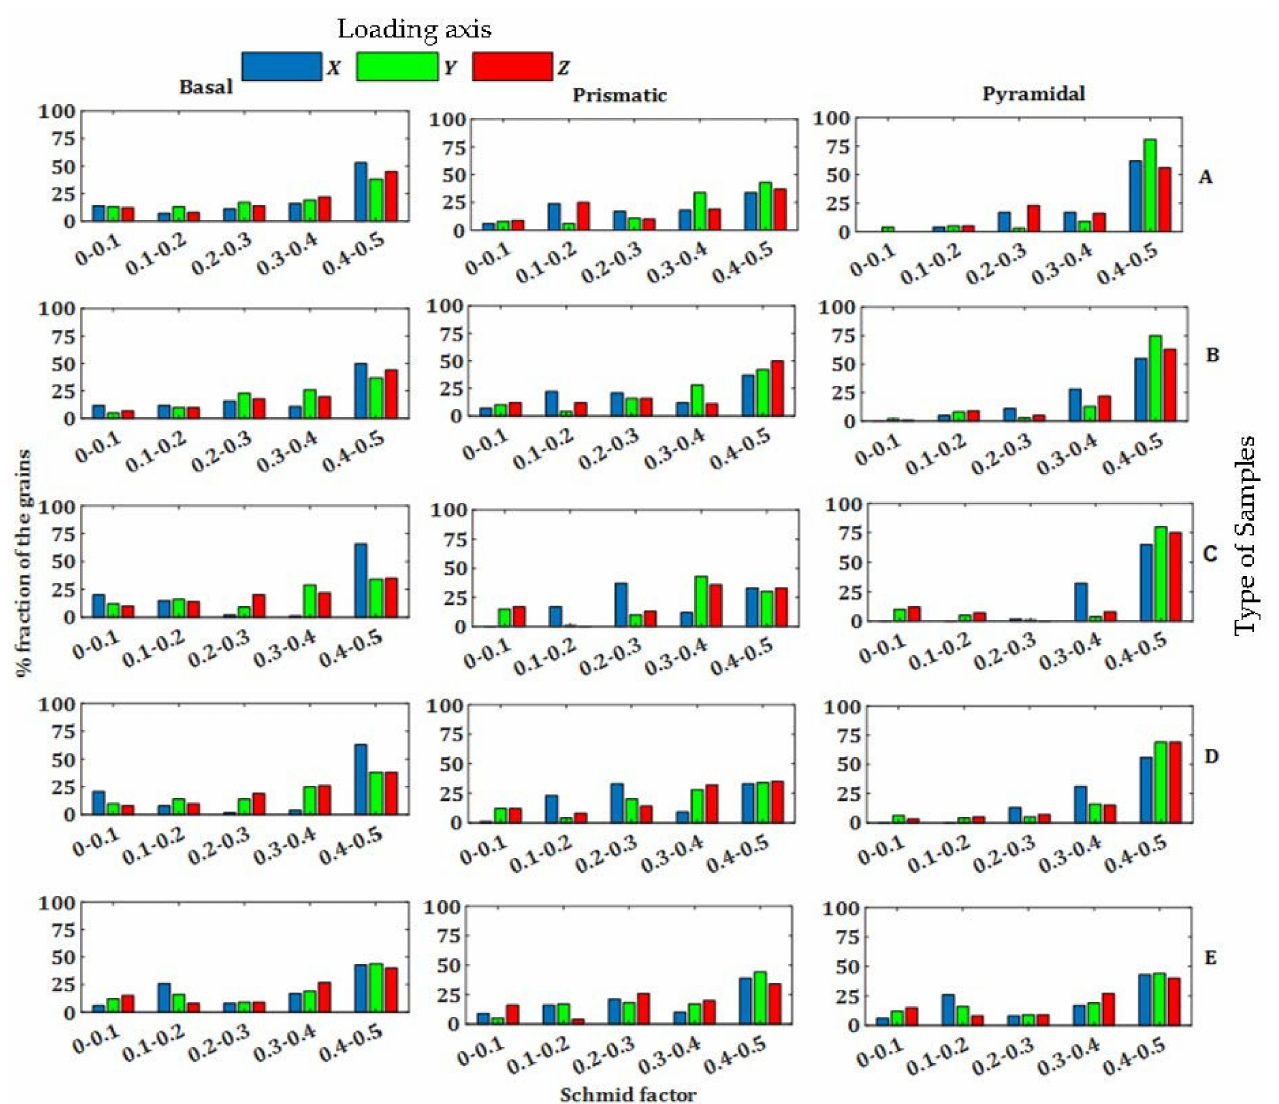
Figure 8. Statistical distribution of the global Schmid factor for basal, prismatic, and pyramidal < α > slip systems in samples type ( A – E